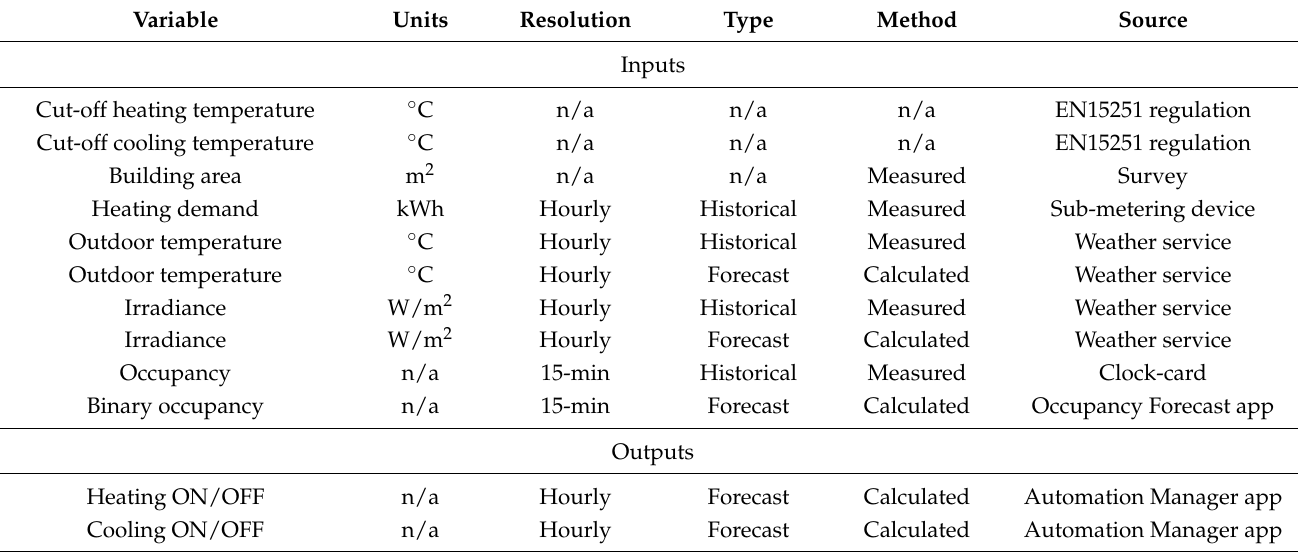
Table 14. Detailed list of inputs and outputs for Automation Manager